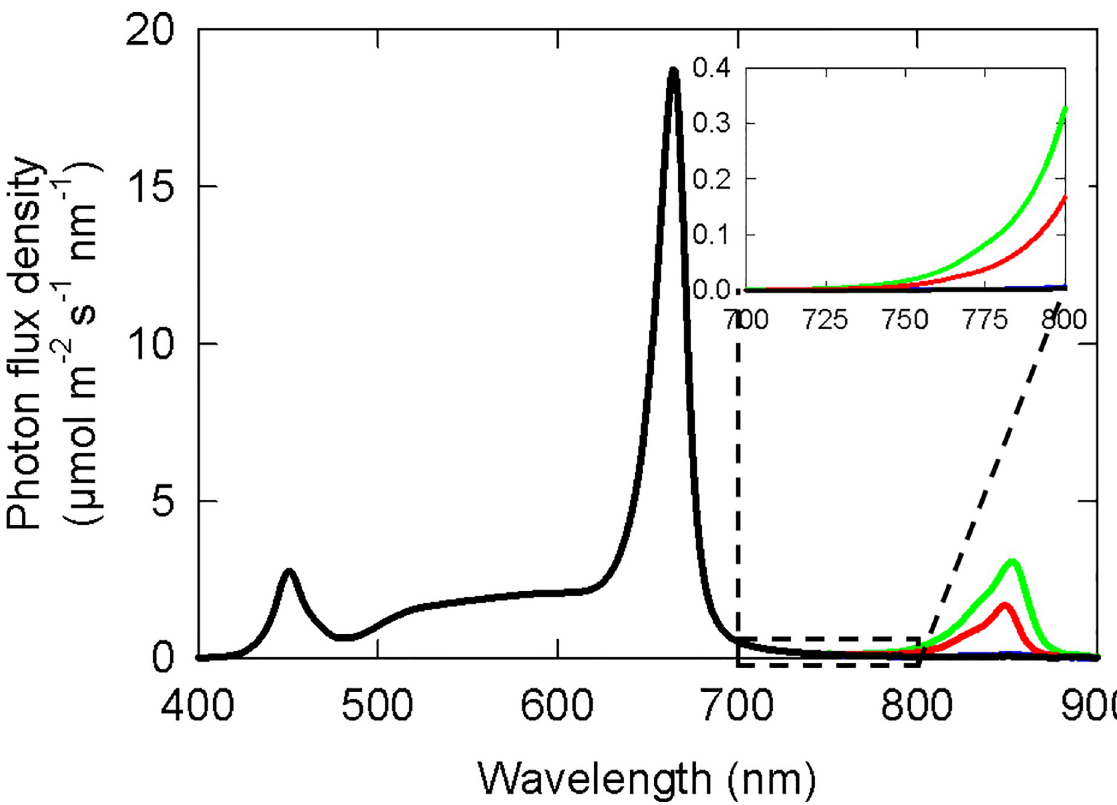
Fig 2. Spectral distribution from cannabis studies. The black line is the background spectral distribution used in all treatments including the control. The red and green lines show the two intensities of added photons from a near-infrared (NIR) LED (low NIR and high NIR in Table 2) across the three replicate studies. Inset: Spectral distribution between 700 and 800 nm of nighttime light pollution from NIR LEDs. Spectral distributions in the soybean study had the same shapes but with lower overall intensities.